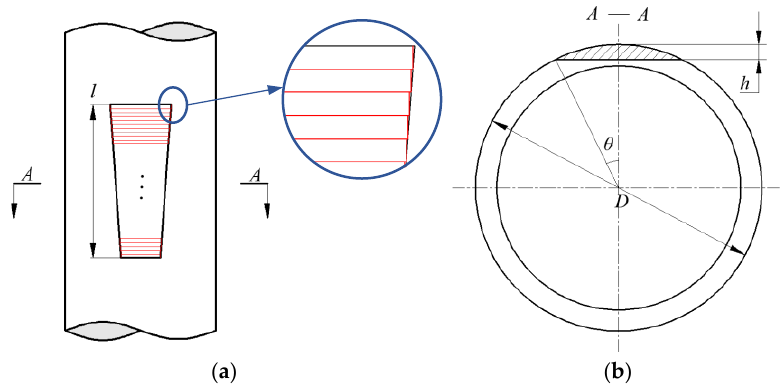
Figure 10. Irregular flat-shaped wear scar: ( a ) n regular flat-shaped scars; ( b ) wear scar in A-A view.